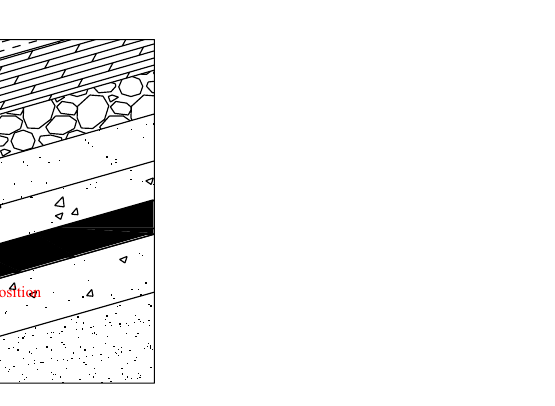
Figure 1. Three roadway location layout under coal pillar.